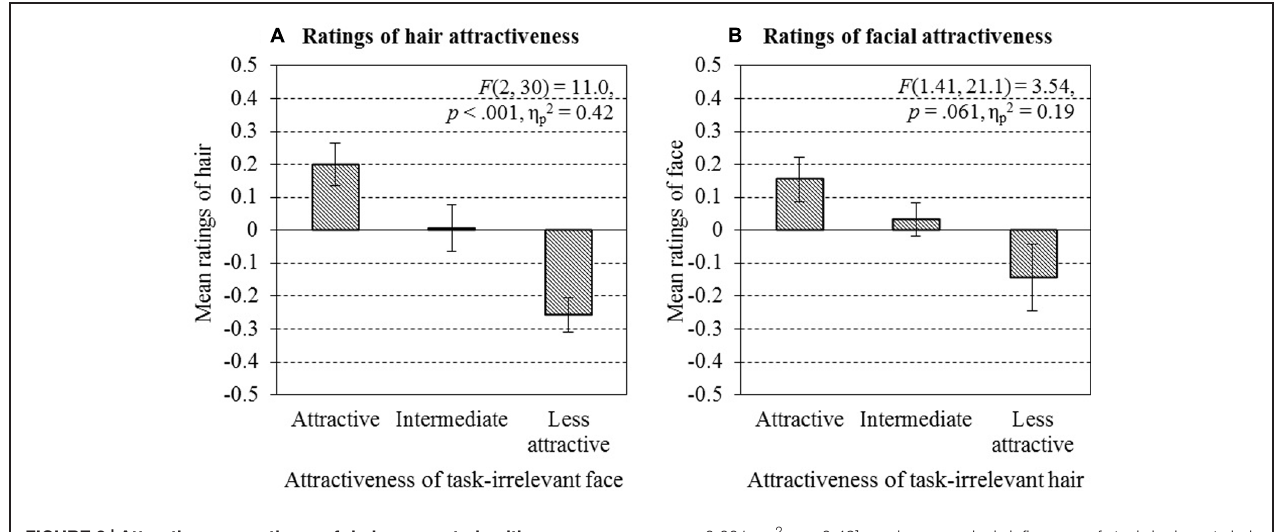
p < 0.001, η 2 p = 0.42] and a marginal influence of task-irrelevant hair on face [ F (1.41,21.1) = 3.54, p = 0.061, η 2 p = 0.19], using degrees of freedom corrected with Greenhouse–Geisser estimates of the